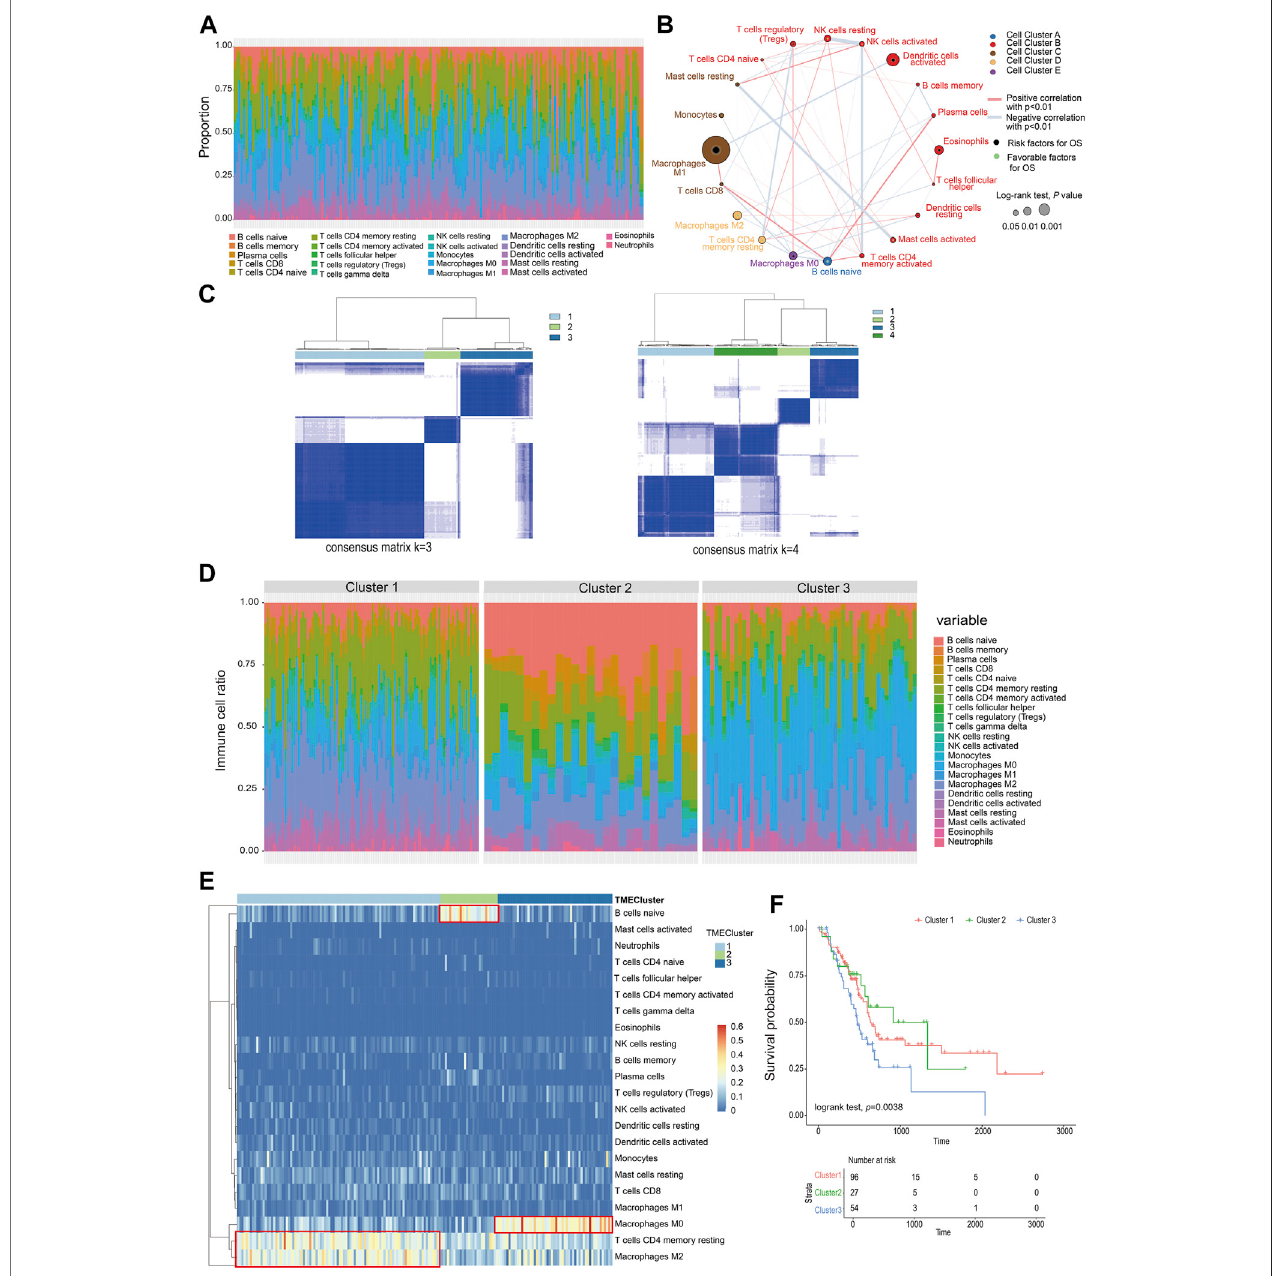
FIGURE 1 | Classi fi cation of in fi ltrating cells and tumor microenvironment. (A) The proportion of 22 types of immune cells in the PC sample. (B) The relationship between the 22 types of immune cells and their survival (the size of the point represents the correlation between the cell and survival and the thickness of the line represents the correlation between the cells). (C) Consensus matrix heat map. (D) The proportion of immune cells in different TMEcluster. (E) Heat map of different TMEcluster immune cells. (F) Different TMEcluster survival